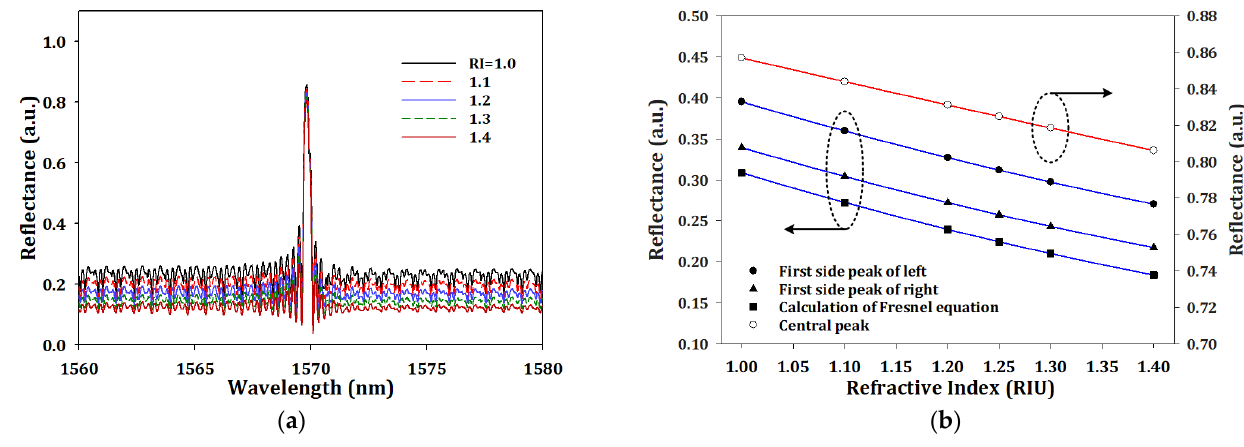
Figure 6. ( a ) The simulation output spectrum and ( b ) the trends in different peak wavelengths with different environmental refractive index.